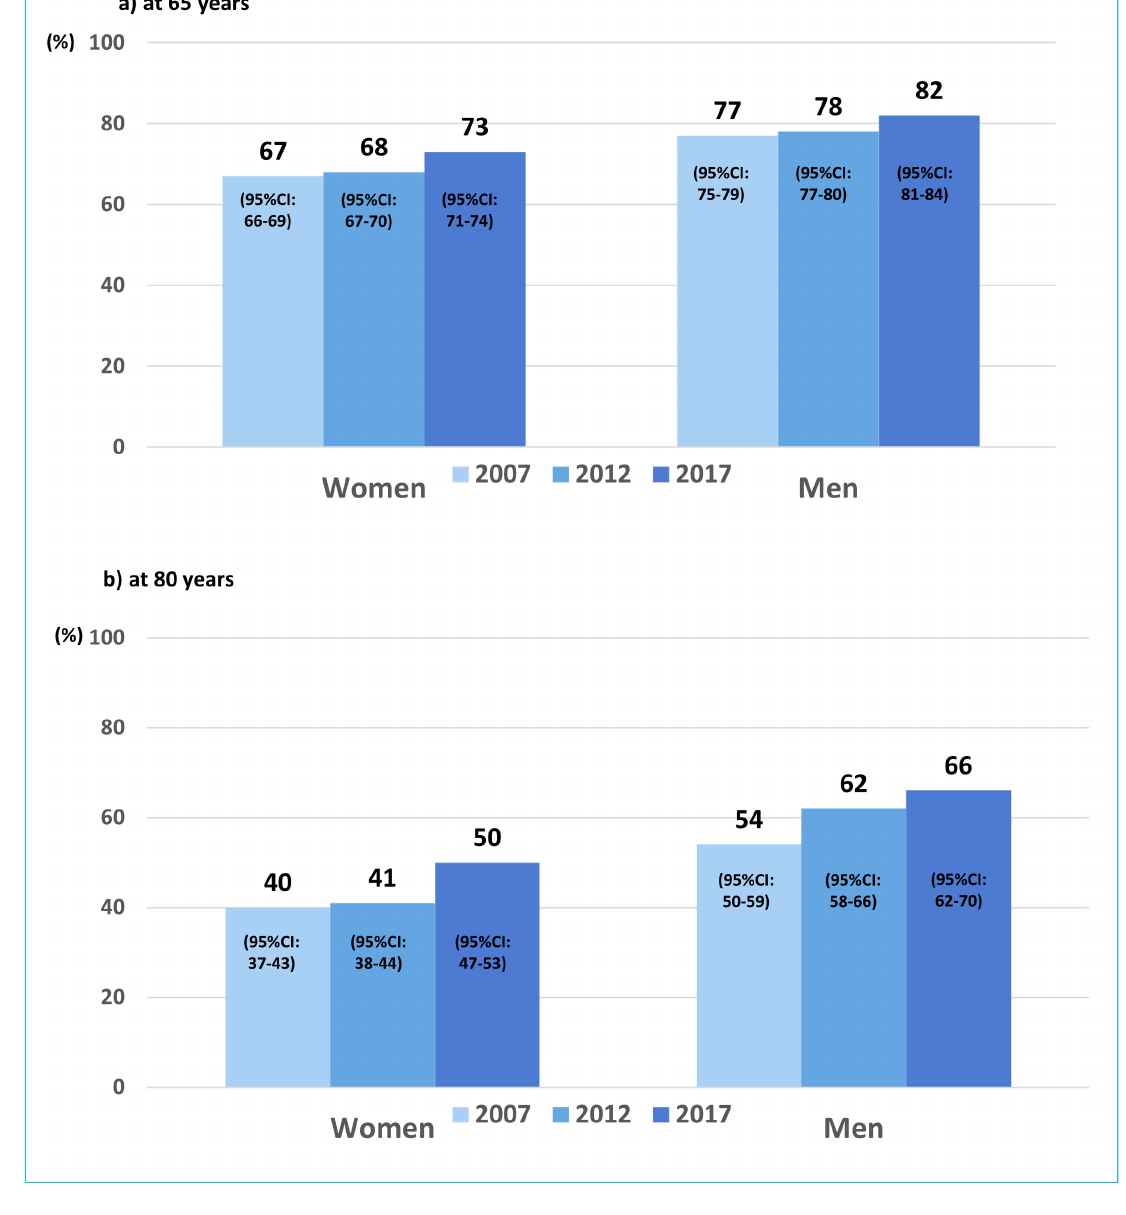
Figure 2: Change in the proportion of disability-free life expectancy in remaining years in women and men, at a) 65 years; b) 80 years of